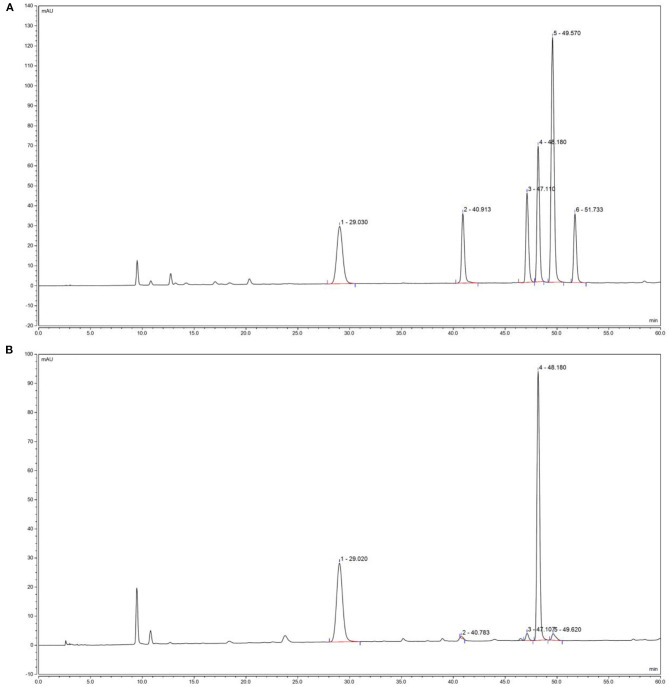
Polysaccharides constituents of blood cora. (A) Standard chromatograms; (B) blood cora polysaccharides chromatograms. 1: mannitol; 2: ribose; 3: anhydrous glucose; 4: galactose; 5: xylose.